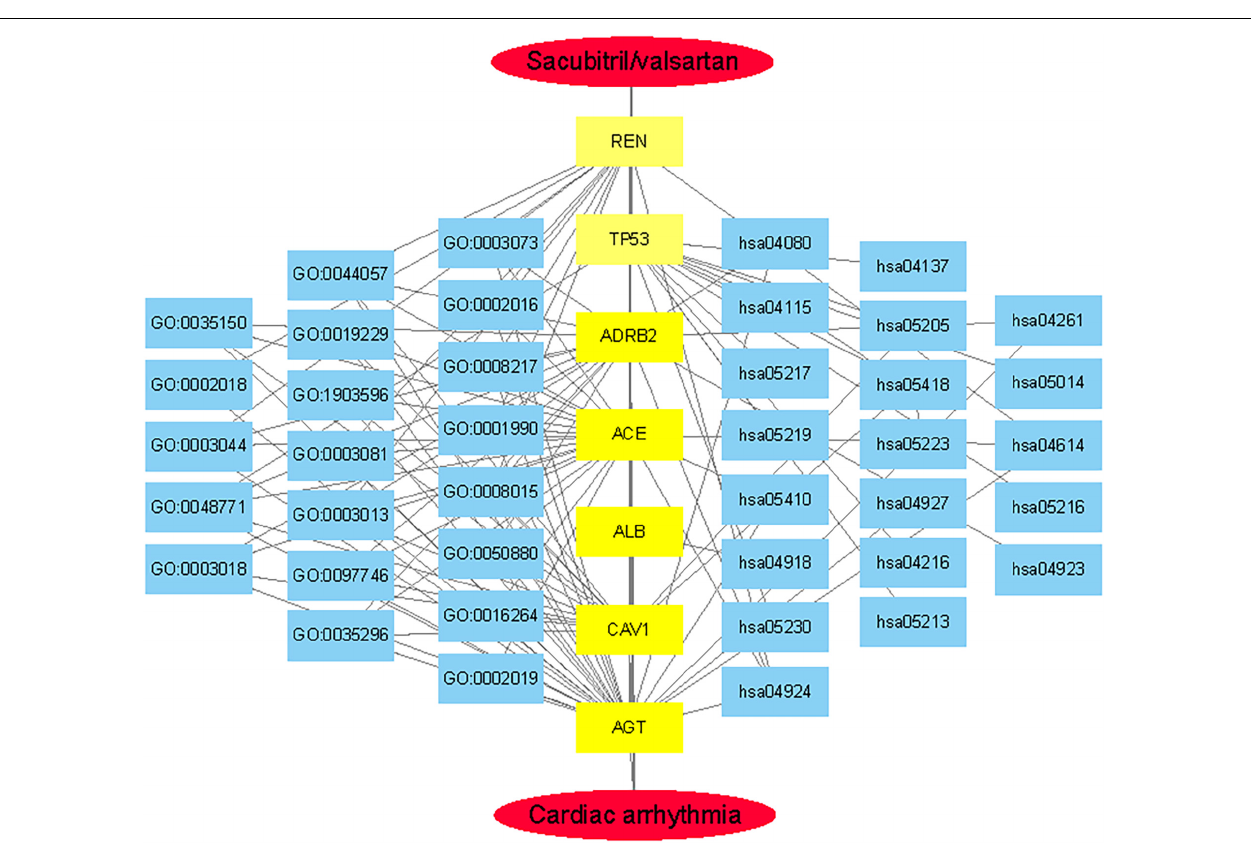
Frontiers in Cardiovascular Medicine |